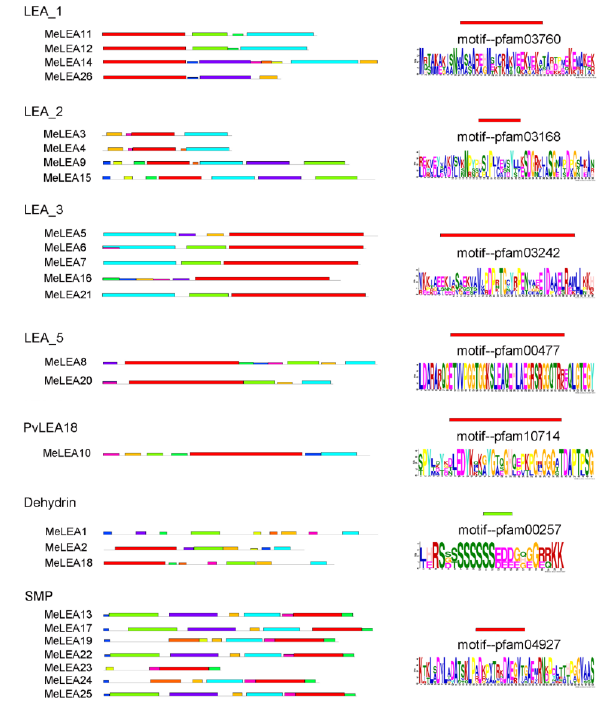
Figure 2. The conserved motifs of the MeLEAs according to the evolutionary classification. The conserved motifs were identified by the MEME database. The coloured boxes represent conserved motifs and grey lines represent the non-conserved sequences. The representative motif of each subfamily was annotated by PFAM databases with Pfam codes.